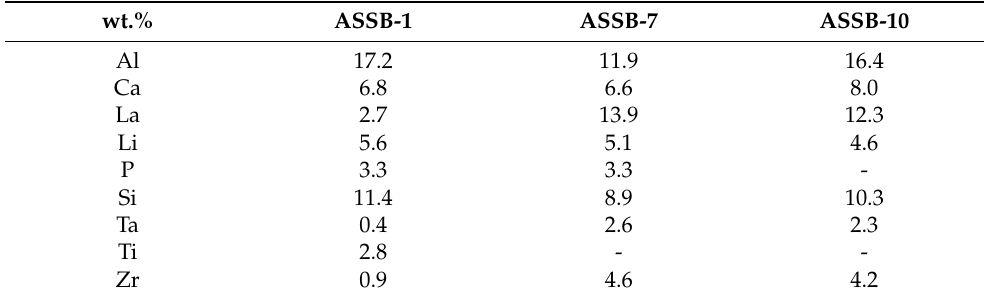
Table 3. Chemical bulk compositions of three SyS samples.